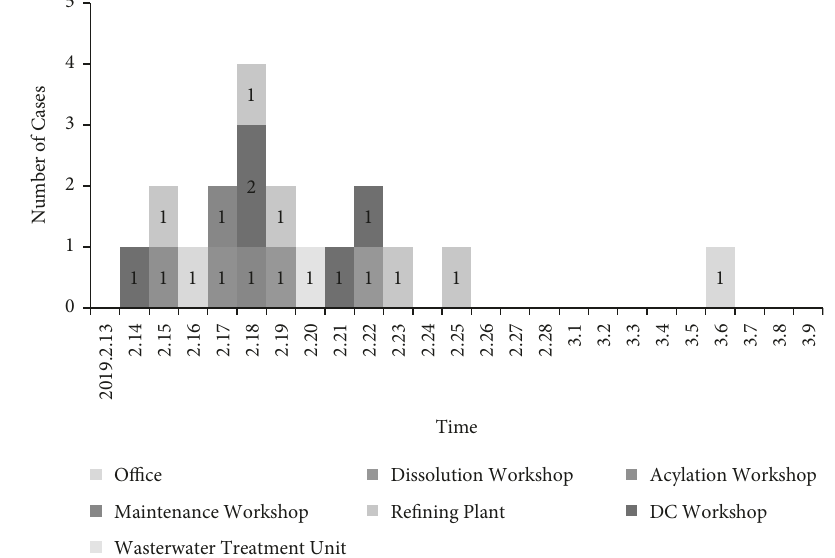
Figure 2: Epidemic curve of 19 cases involved in this